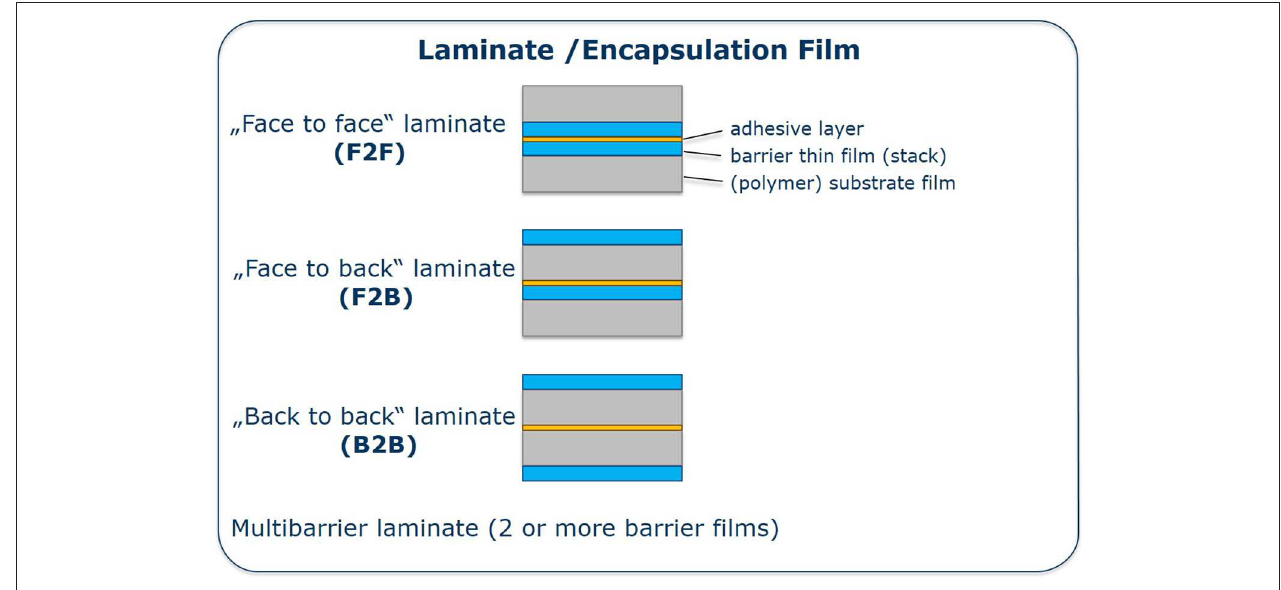
FIGURE 8 | Notation of laminate types as used in this review.